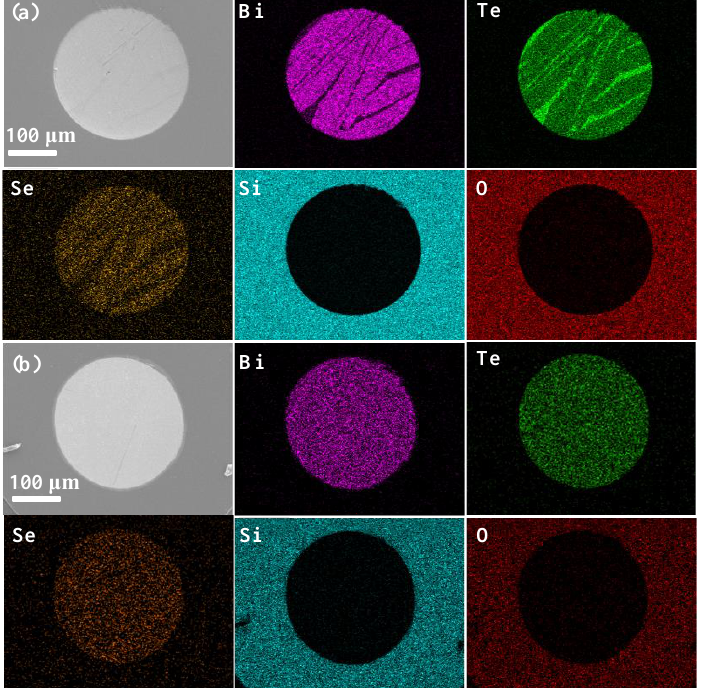
Figure 3. Cross-section SEM image and EDS elemental mapping of ( a ) the as-drawn and ( b ) the Bridgman annealed n-type Bi 2 Te 3 -based fiber.